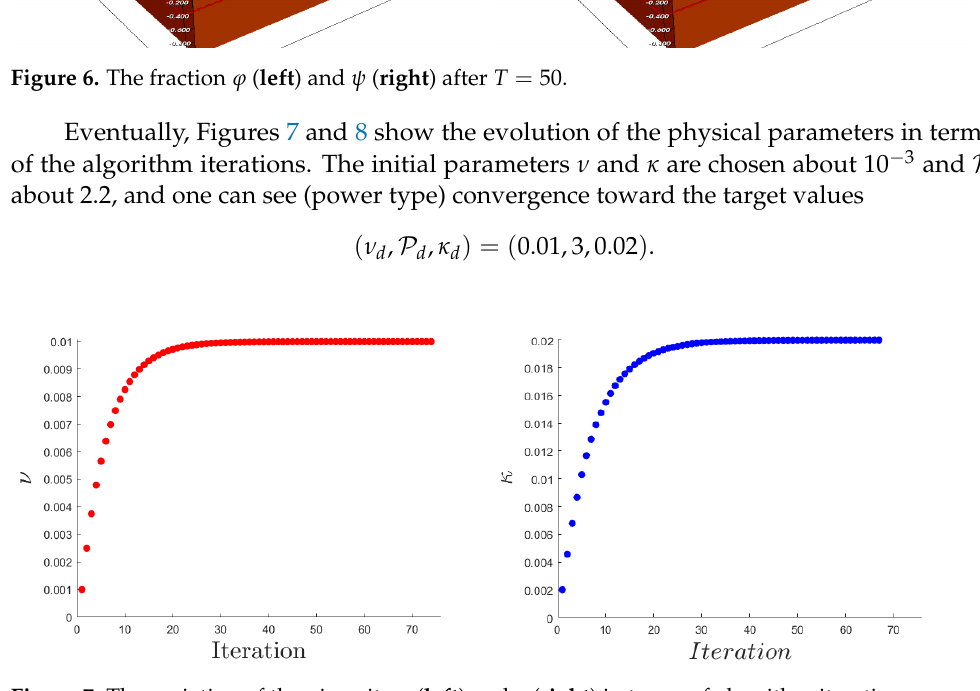
Figure 7. The variation of the viscosity ν ( left ) and κ ( right ) in terms of algorithm iterations.